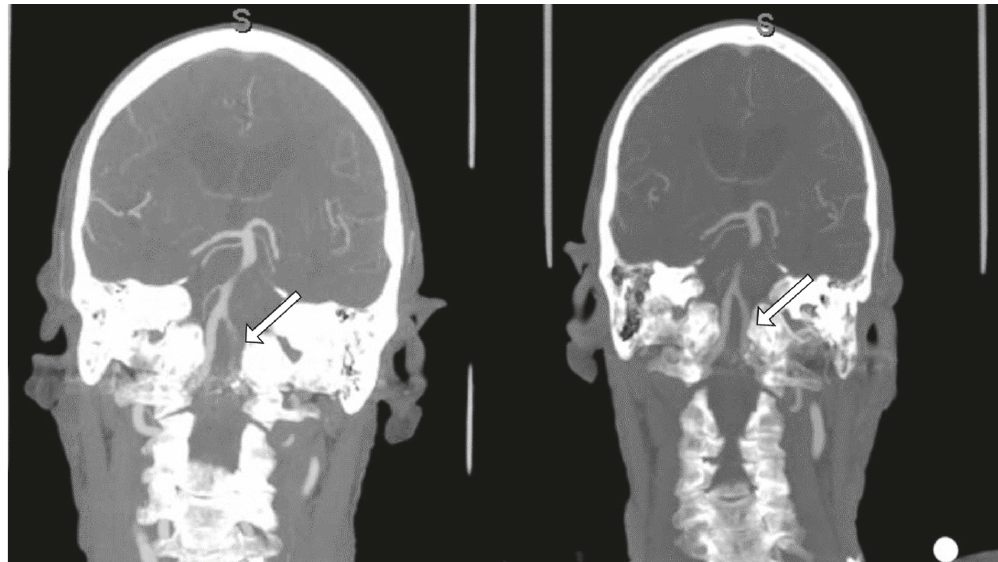
Figure 1: CTA neck coronal MIP planes, (left panel) showing intraluminal thrombus of V4 segment of left vertebral artery (arrow) before cerebral angiogram. Right panel showing patent V4 segment of left vertebral artery (arrow) with resolution of previously seen thrombus.